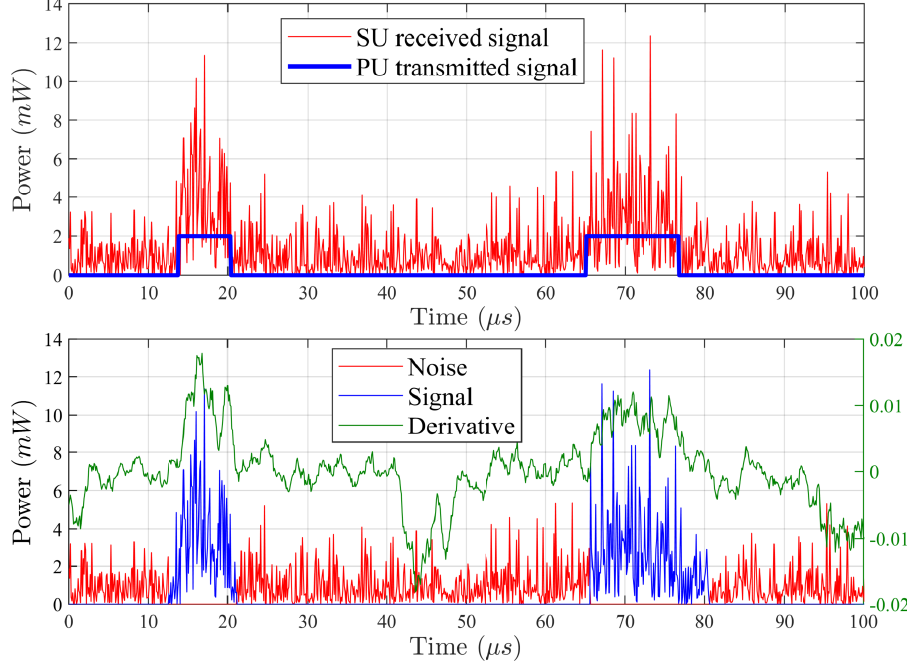
Figure 3. An instance of analyzed time frame: ( top )—the time frame with RF noise and PU pulse signals with randomly distributed durations. ( bottom )—splitting of signal and noise samples based on the processed sign of the